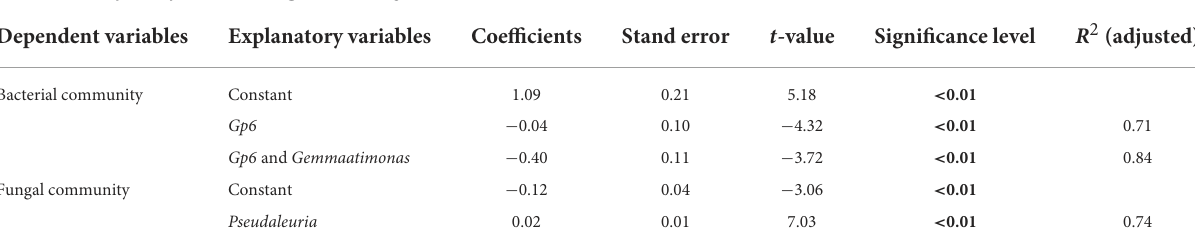
TABLE 3 Multiple stepwise linear regression